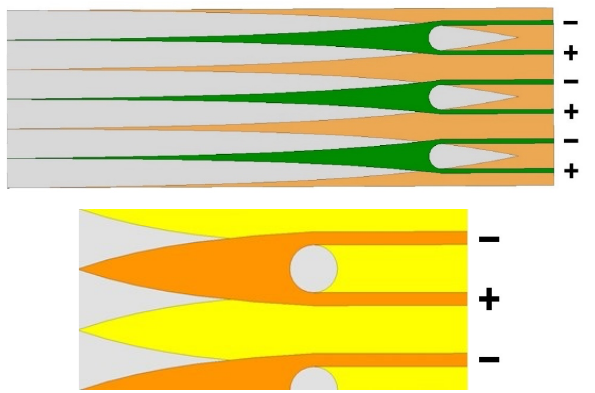
FIGURE 8. Phase Difference distribution inside a WR90 Hexa-FLuS and a Triple